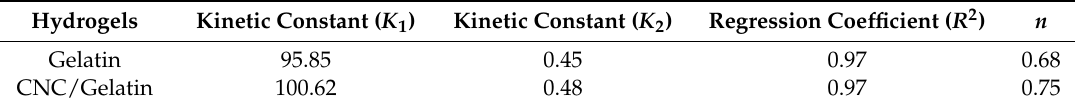
Table 2. Fitting paramaters obtained from the Peppas-Sahlin